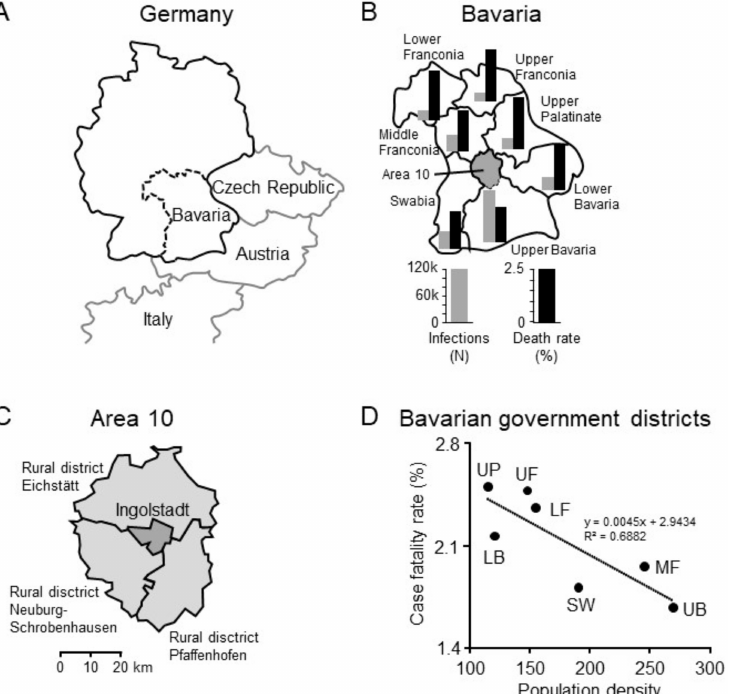
Figure 1. COVID-19 incidence and case-fatality rates in Bavaria, the Bavarian districts, and locally in the city of Ingolstadt. ( A ) Bavaria is Germany’s largest federal state, bordering Austria, the Czech Republic, and lies in close proximity to northern Italy. ( B , C ) The geographic “Area 10” of Bavaria, located in the northern part of Upper Bavaria, is composed of the city of Ingolstadt and three rural districts totaling about 500,000 inhabitants. ( D ) Case-fatality rates of Bavarian government districts correlate negatively to the corresponding population densities. LB = Lower Bavaria; LF = Lower Fran- conia; MF = Middle Franconia; UB = Upper Bavaria; UF = Upper Franconia; UP = Upper